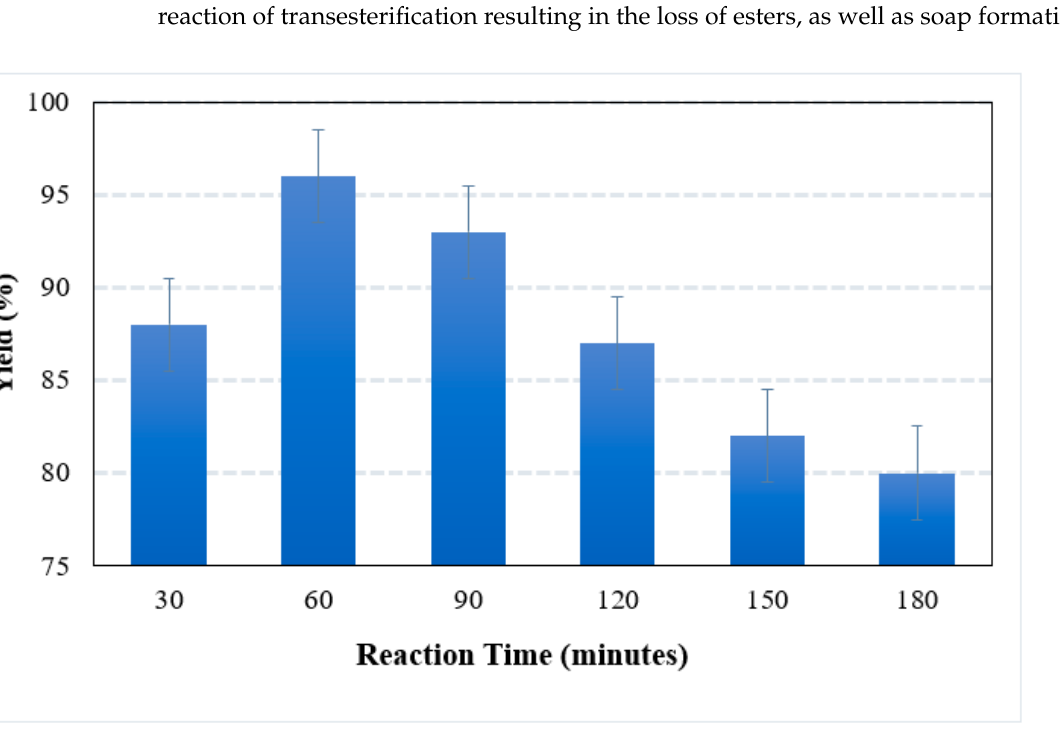
Figure 8. Effect of reaction temperature on biodiesel production.